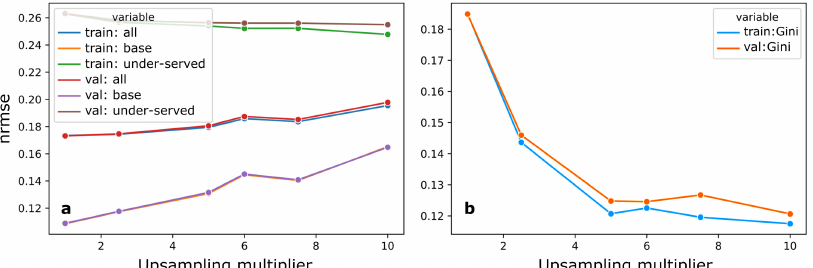
Fig. 7 Effect of upsampling multiplier on performance metrics. Panel ( a ) shows NRMSE for the entire dataset, the base group and the under- served group, for training and validation sets. Panel ( b ) shows the Gini coef fi cient. In both training and validation sets, increasing the upsampling multiplier improved model performance on the under-served group, while negatively affecting performance on the base group and overall. The Gini coef fi cient tended to drop as upsampling increased, mostly indicating increased equity in the distribution for higher levels of